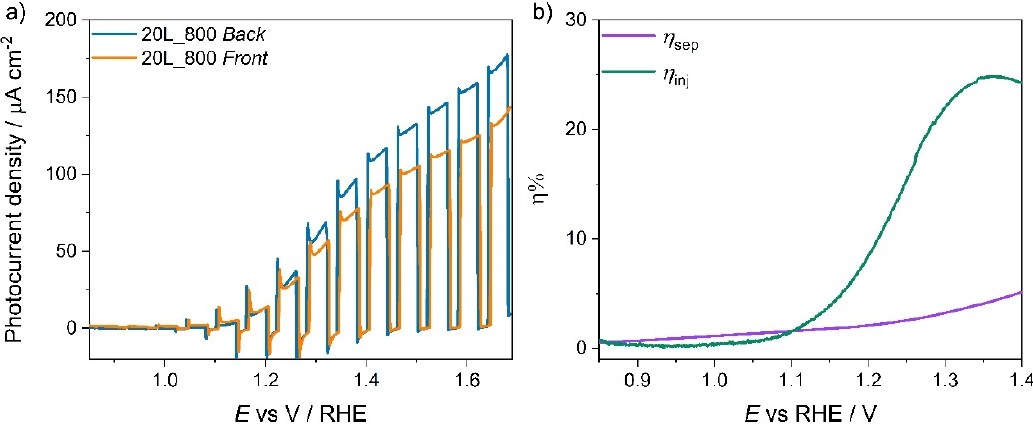
Figure 5. ( a ) Linear Sweep Voltammetry (LSV) plots relative to the 20L_800 °C film in 1.0 M NaOH under both back and front side irradiation configurations. ( b ) Charge separation ( η sep ) and charge injection efficiencies ( η inj ) calculated for the same film.